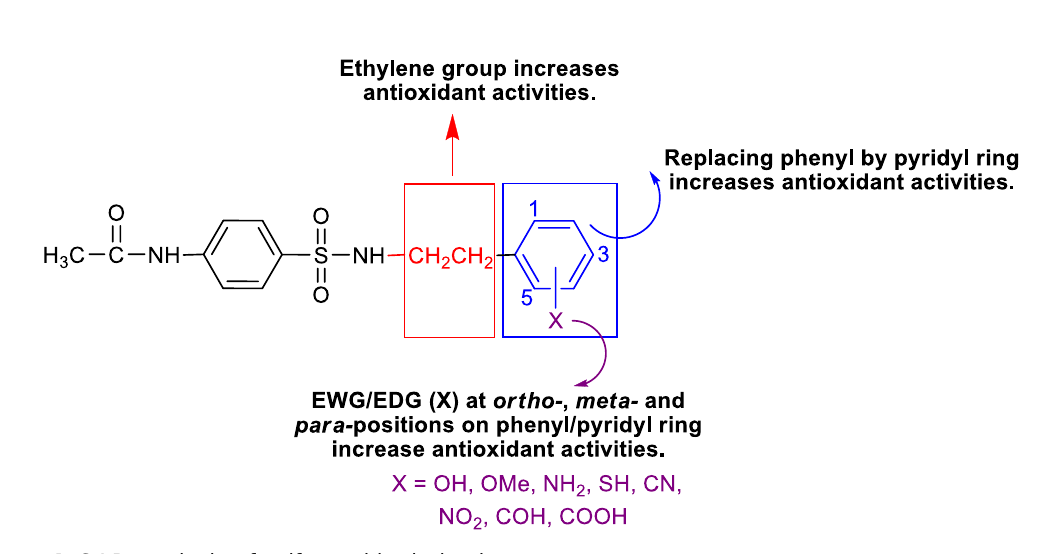
Figure 4: SAR analysis of sulfonamide